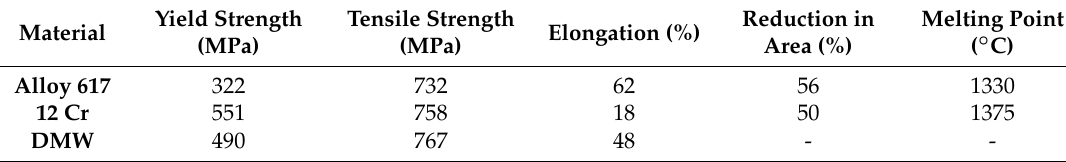
Table 2. Mechanical properties of Alloy 617, 12 Cr steel, and